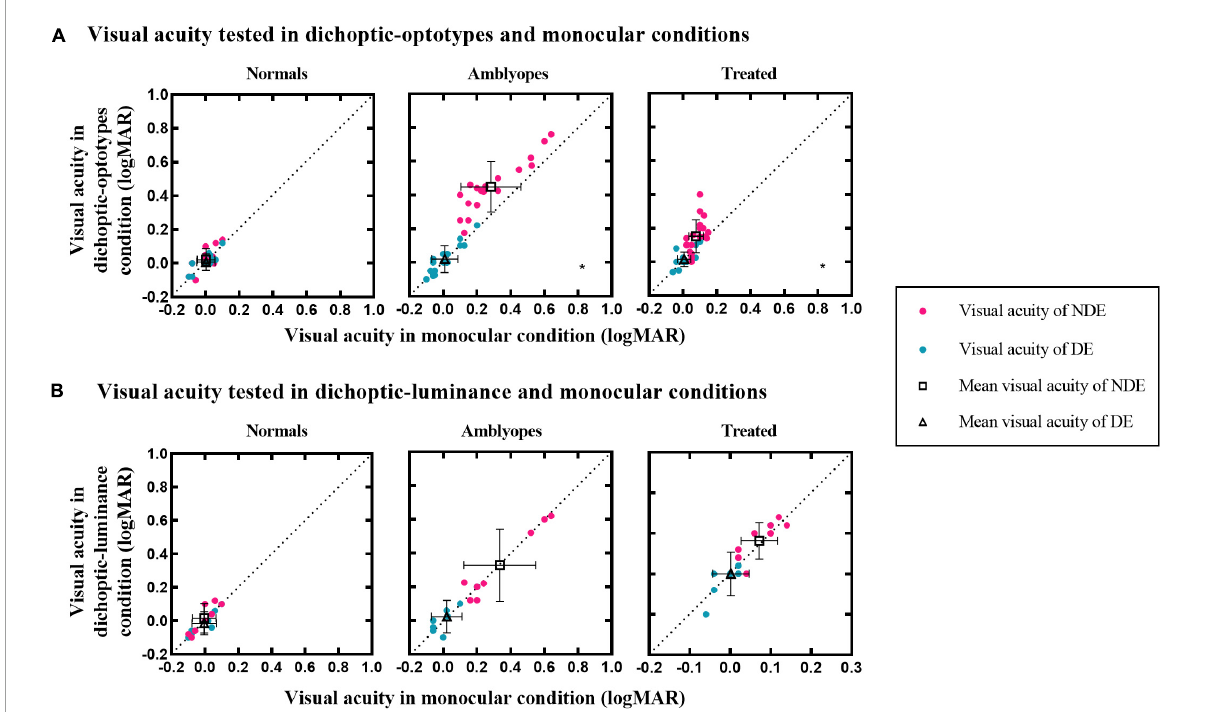
FIGURE2 Visual acuity of the three groups in different test conditions. (A) Visual acuity under dichoptic-optotypes condition as a function of visual acuity under monocular condition. (B) Visual acuity under dichoptic-luminance condition as a function of visual acuity under monocular condition. The black dotted lines indicate the same visual acuity under two conditions. Black hollow squares and black hollow tangles represent mean visual acuity of the NDE and DE, respectively. Error bars denote the range of ± SD. A black asterisk is on the lower right of the panel which shows significant difference between two test